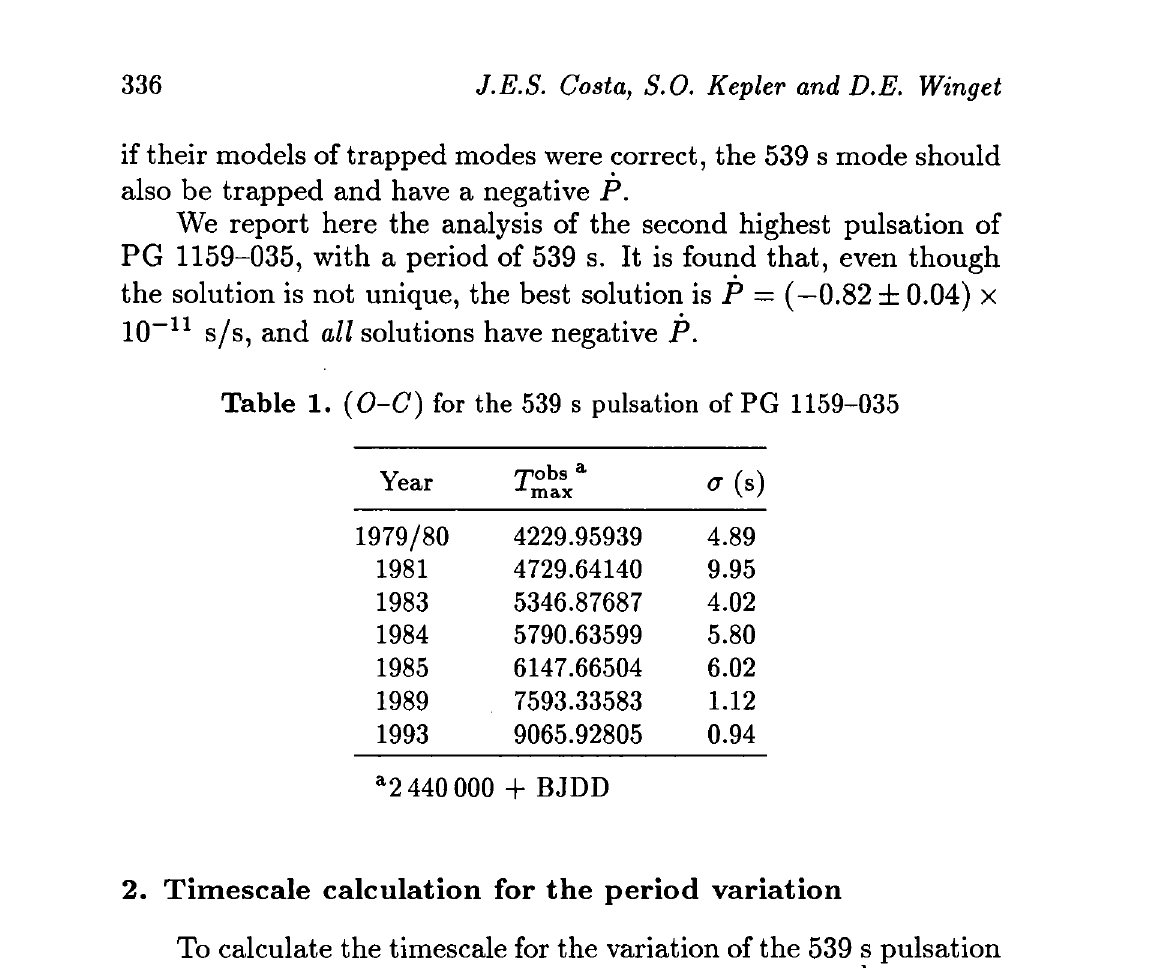
Table 1. ( O-C ) for the 539 s pulsation of PG